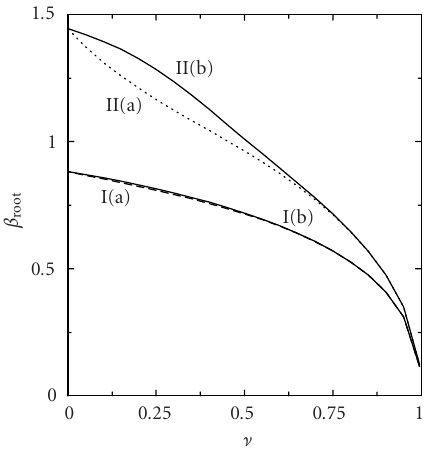
Figure 4.9. The variation of β root as a function of the nonintegrability parameter ν for a = 1 . 0 and 2 . 0, as obtained from the exact calculation. Since λ = − 1, these states are staggered stationary localized states. Curve I(a): a = 1 . 0, and x 0 = 0 . 0. Curve II(a): a = 2 . 0, and x 0 = 0 . 0. Curve I(b): a = 1 . 0, and x 0 = 0 . 5. Curve II(b): a = 2 . 0, and x 0 = 0 .